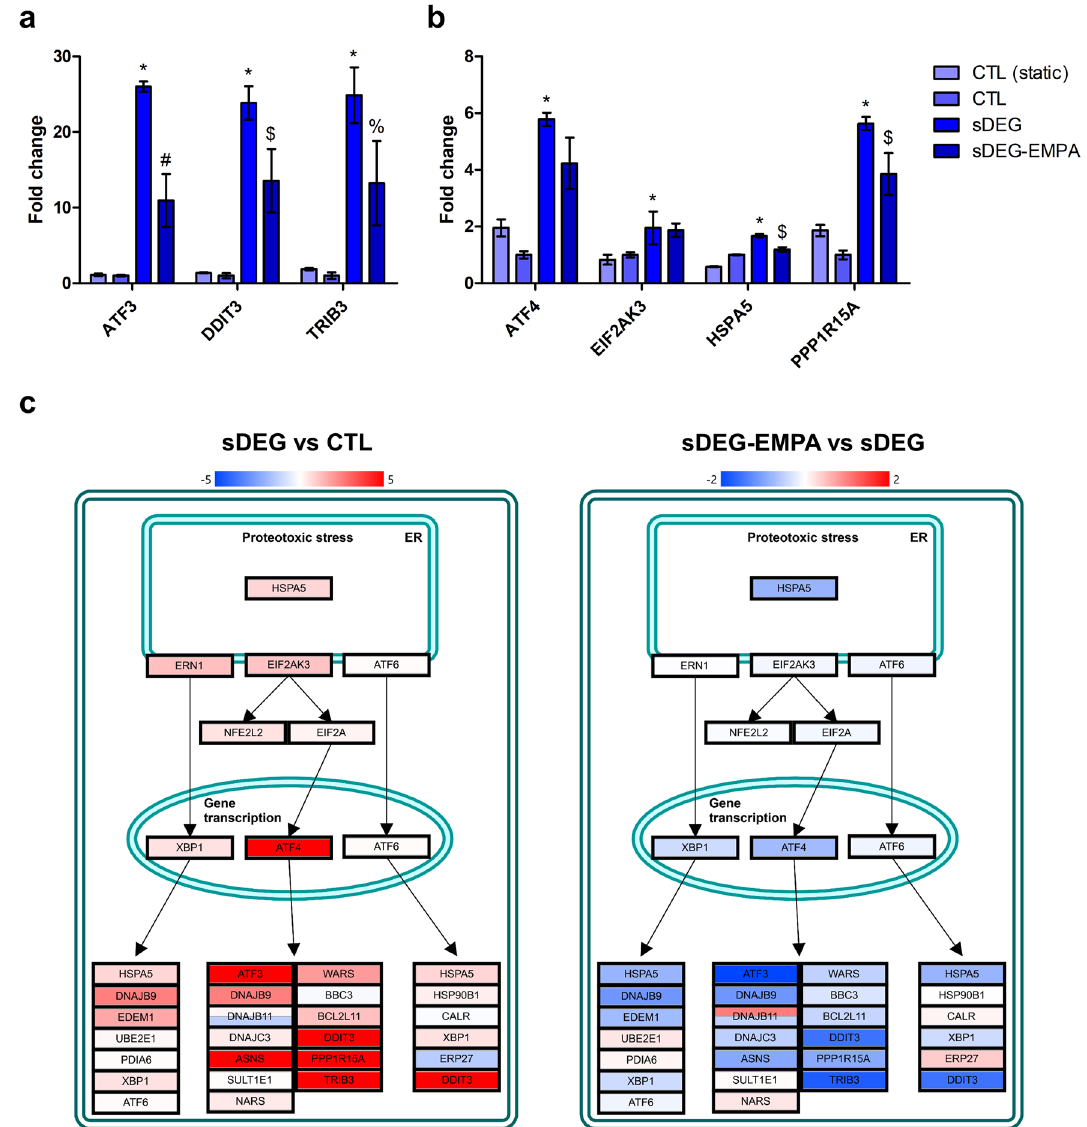
Figure 3. Impact of sustained HS degradation and EMPA treatment on ER stress gene transcription. ( a ) Fold changes of ATF3 , DDIT3 (CHOP), TRIB3 and ( b ) ATF4 , EIF2AK3 (PERK), HSPA5 (GRP78) and PPP1R15A (GADD34). Sustained degradation caused significant fold increases in ATF3 (26.01), ATF4 (5.78), DDIT3 (23.85), EIF2AK3 (1.95), HSPA5 (1.67), TRIB3 (24.86) and PPP1R15A (5.63) expression (sDEG vs CTL *p < 0.001). EMPA significantly reduced the expression of ATF3 (− 2.37), DDIT3 (− 1.76), HSPA5 (− 1.40), PPP1R15A (− 1.46) and TRIB3 (− 1.88) (sDEG-EMPA vs sDEG # p < 0.001, $ p < 0.01, % p < 0.05). ( c ) Simplified ER stress signaling pathway generated from the Transcriptome Analysis Console software showing regulation through the PERK/eIF2/ATF4 branch of the UPR. The original version of the pathway is made available through WikiPathways 25